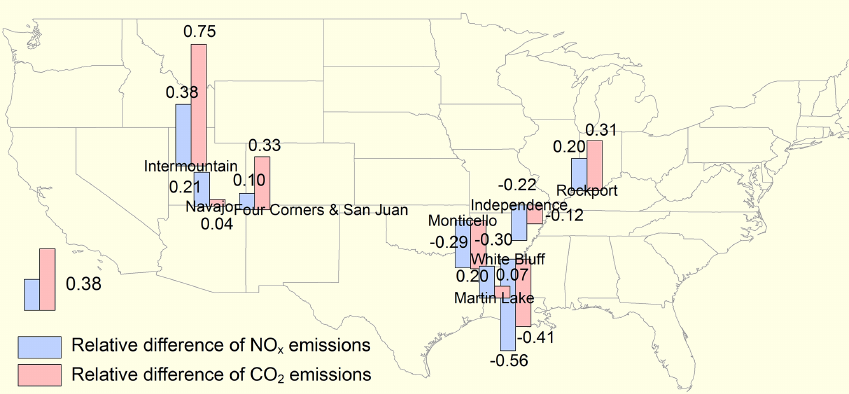
Figure 1. Locations of the power plants investigated in this study. The bar charts denote the relative differences, defined as ( E Sat − E CEMS )/E CEMS , averaged over 2005–2017 for NO x (blue) and CO 2 (red) emissions. The upward and downward bars represent posi- tive and negative differences, respectively. The Monticello power plant installed SNCR to control NO x emissions in 2008. The other power plants are not equipped with post-combustion NO x control